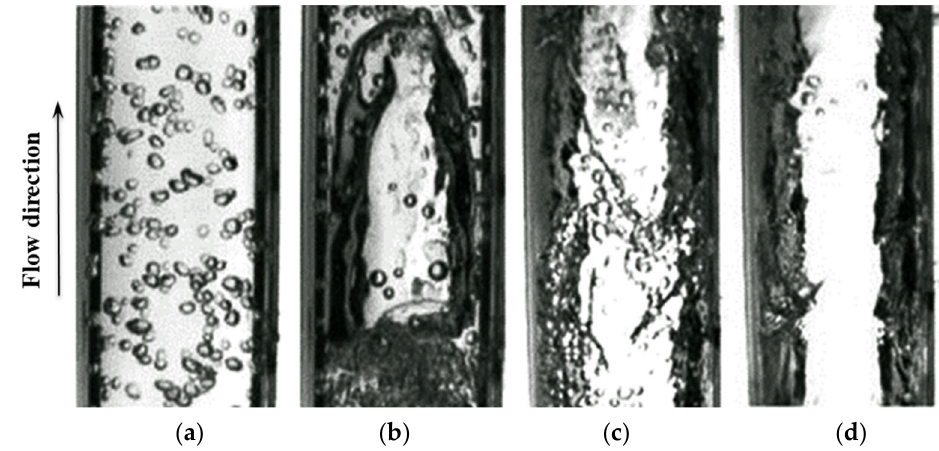
Figure 6. Flow regimes observed in co-current VU two-phase flow in 50.8 mm round pipes. ( a ) Bubbly ( b ) Slug ( c ) Churn-turbulent ( d ) Annular.